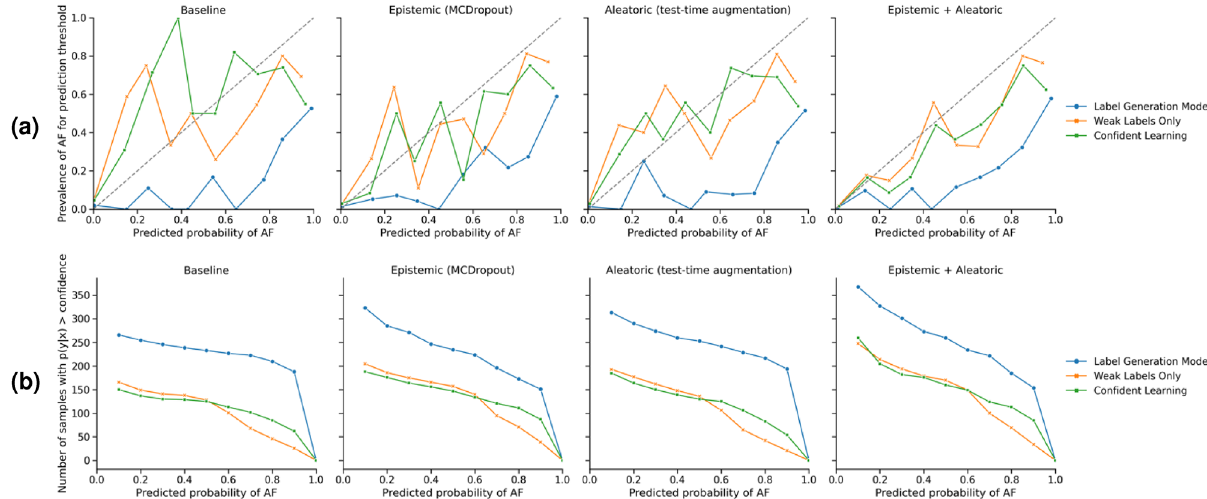
Figure 6. Calibration curves for all three models with various uncertainty estimation techniques applied, as compared to their fully certain baselines. ( a ) reliability curve of predicted probability (confidence) thresholds and the prevalence of the positive AF class from 0 (100% probability of sinus rhythm) to 1 (100% probability of the AF class). The dashed gray line represents a perfect calibration curve. ( b ) confidence versus number of samples with probability greater than the confidence